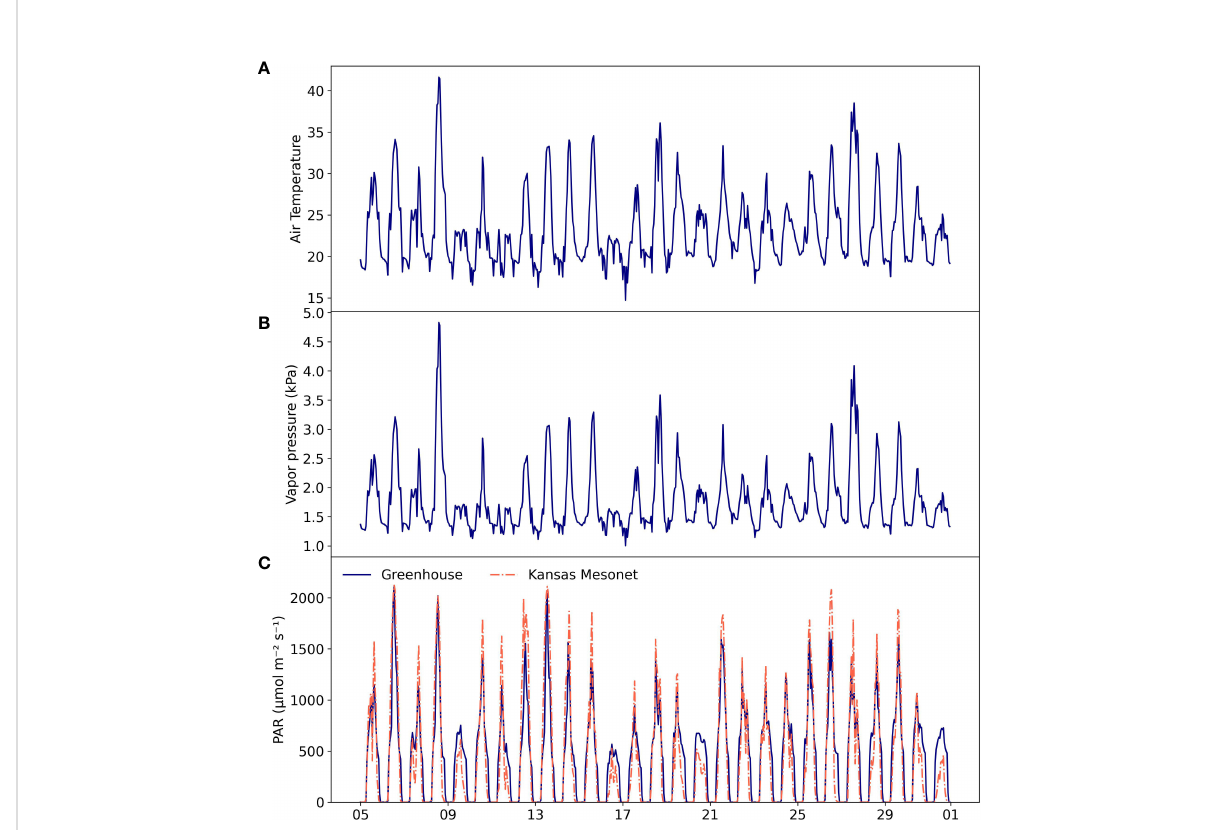
FIGURE 3 Air temperature (A) , vapor pressure de fi cit (B) , and greenhouse and outdoors photosynthetically active radiation (PAR, 389-692 nm) (C)